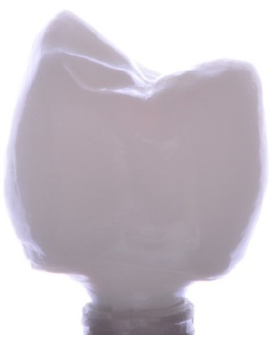
Figure 4. Stereolithography (SLA) additive manufacturing (AM) of implant supported zirconia crown after cementation.